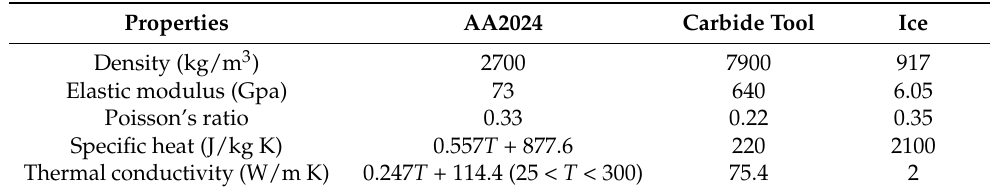
Table 1. Physical properties of workpiece, tool materials and ice.